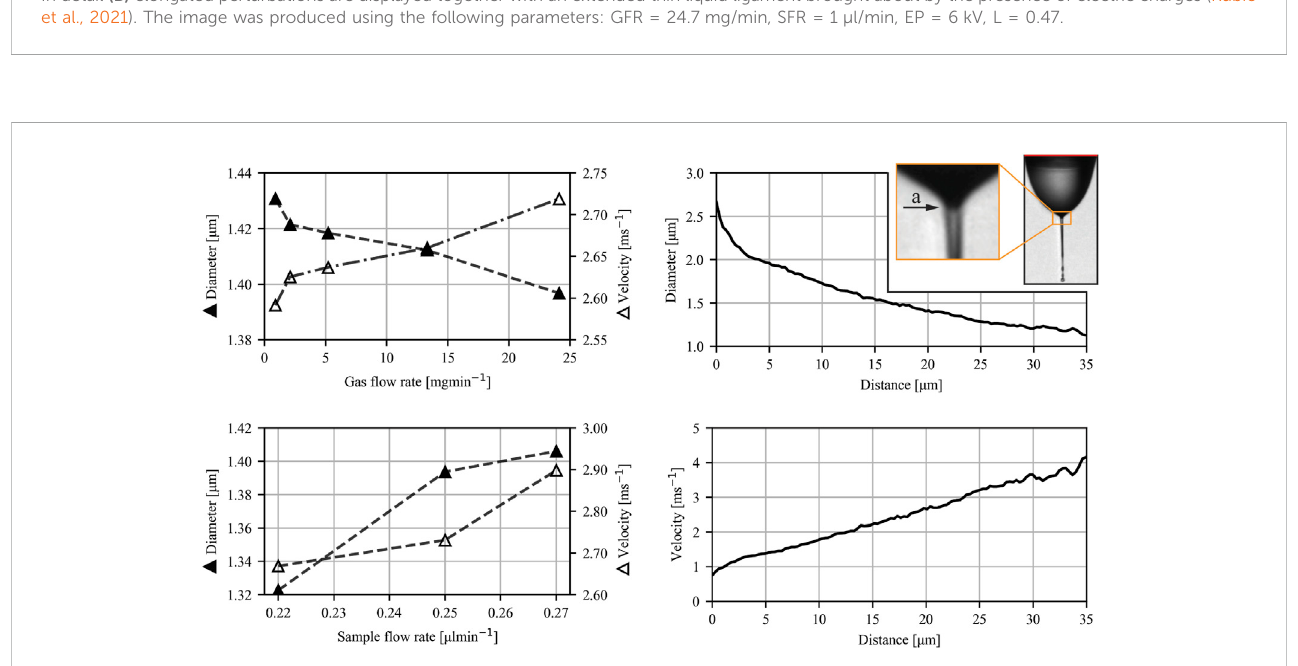
FIGURE 7 Diameter and velocity pro fi les for atmospheric pressure conditions. Figures on the left show the in fl uence of the gas and sample fl ow rates on jet diameter and velocity 20 μ m downstream of themeniscus-to-jet transition(denoted byan arrow (a) shown in theinsert on theright).The fi gures on the right represent the typical diameter (solid triangle) and velocity pro fi le (open triangle) as a function of distance from the meniscus-to-jet transition of a jet under atmospheric pressure. EP = 7 kV for all